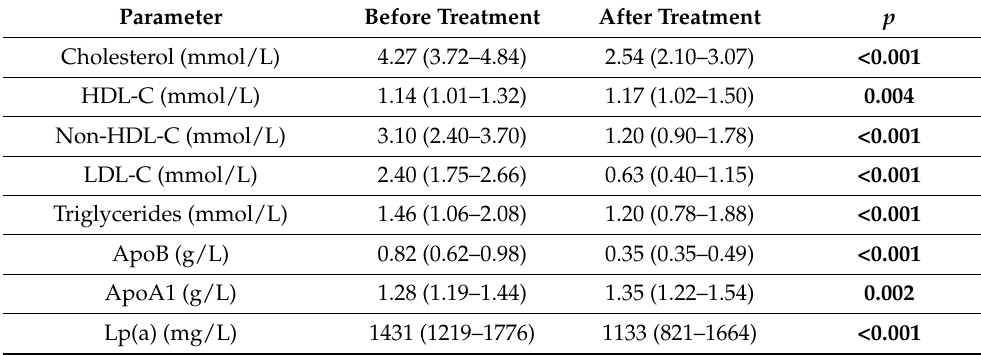
Table 3. Comparison of laboratory parameters before and after treatment with PCSK9